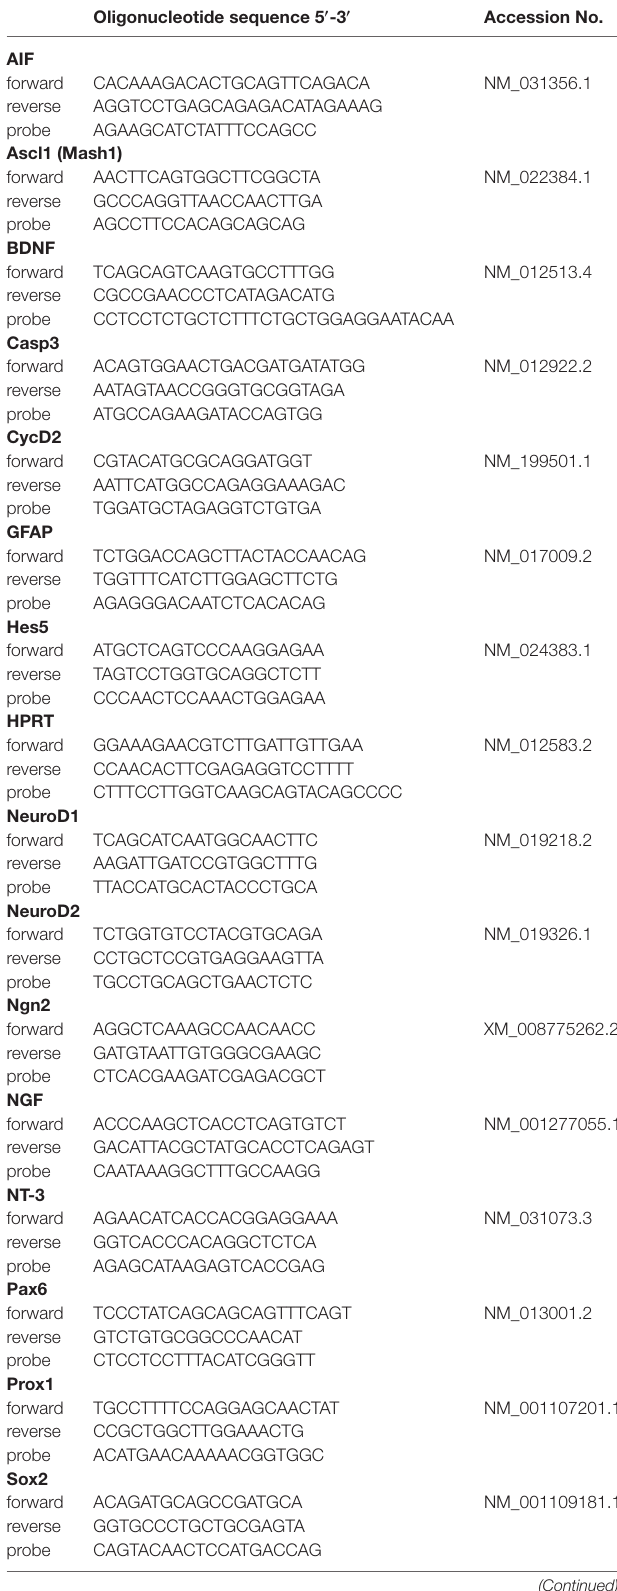
TABLE 1 | Sequences of oligonucleotides. Oligonucleotide sequence 5 (cid:48) -3 (cid:48) Accession